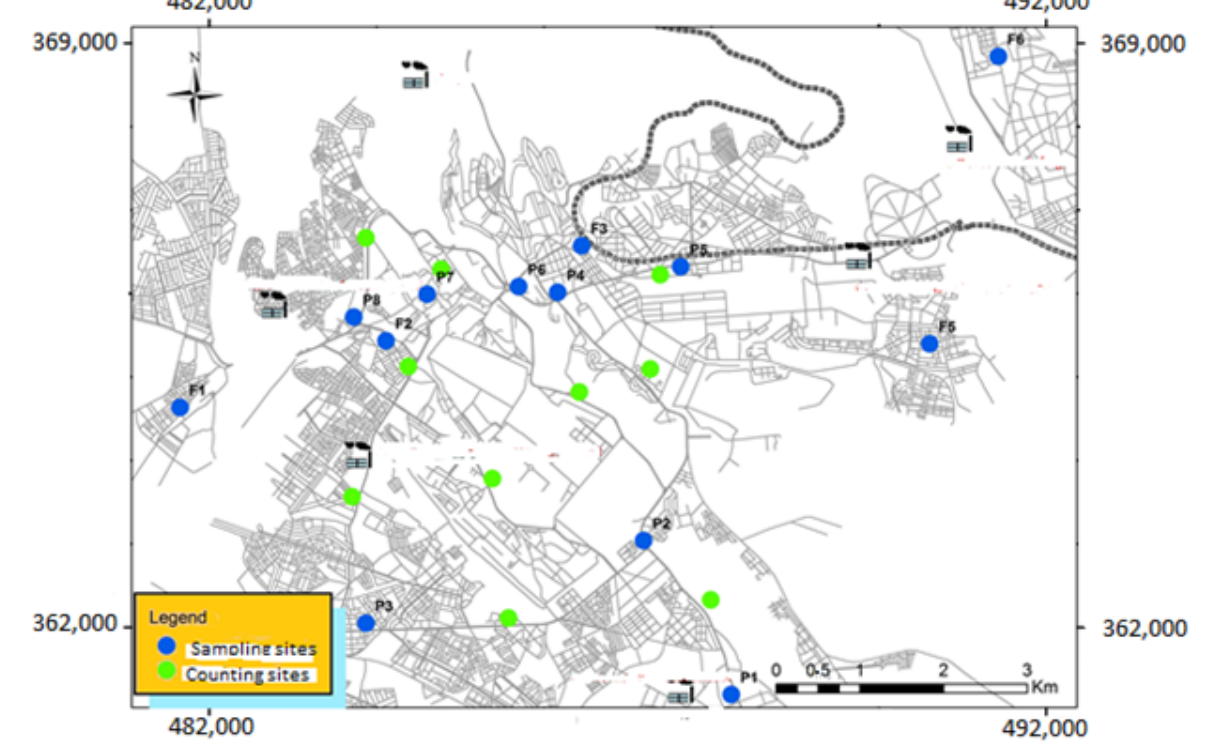
Figure 3. Location of counting sites.